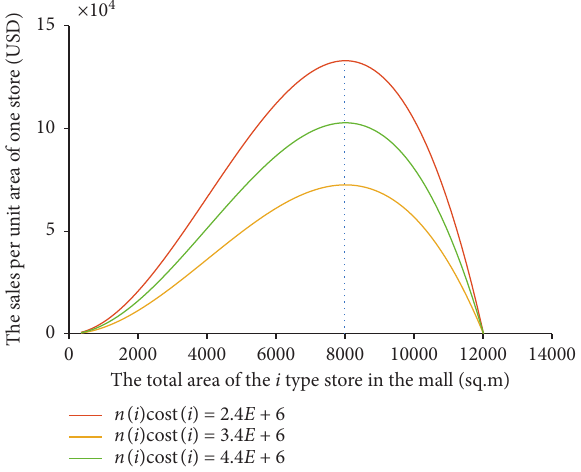
Figure 7: Alternative consumption ability.